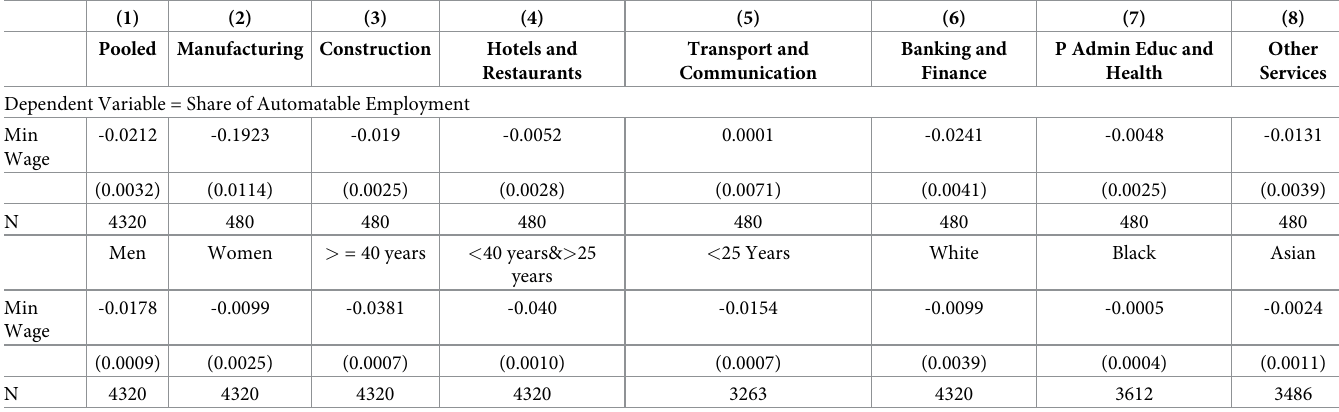
Table 4. Alternative minimum wage